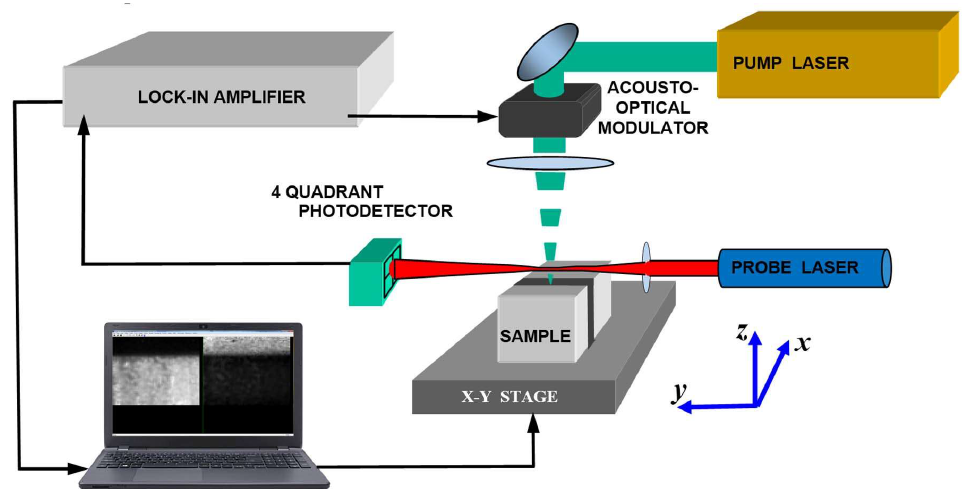
Figure 1. General scheme of the laser thermal wave microscope with the probe-beam deflection sensing.